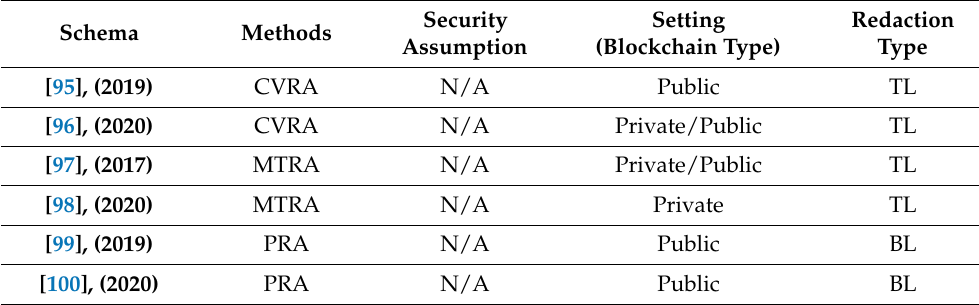
Table 3. Non-chameleon redaction approaches